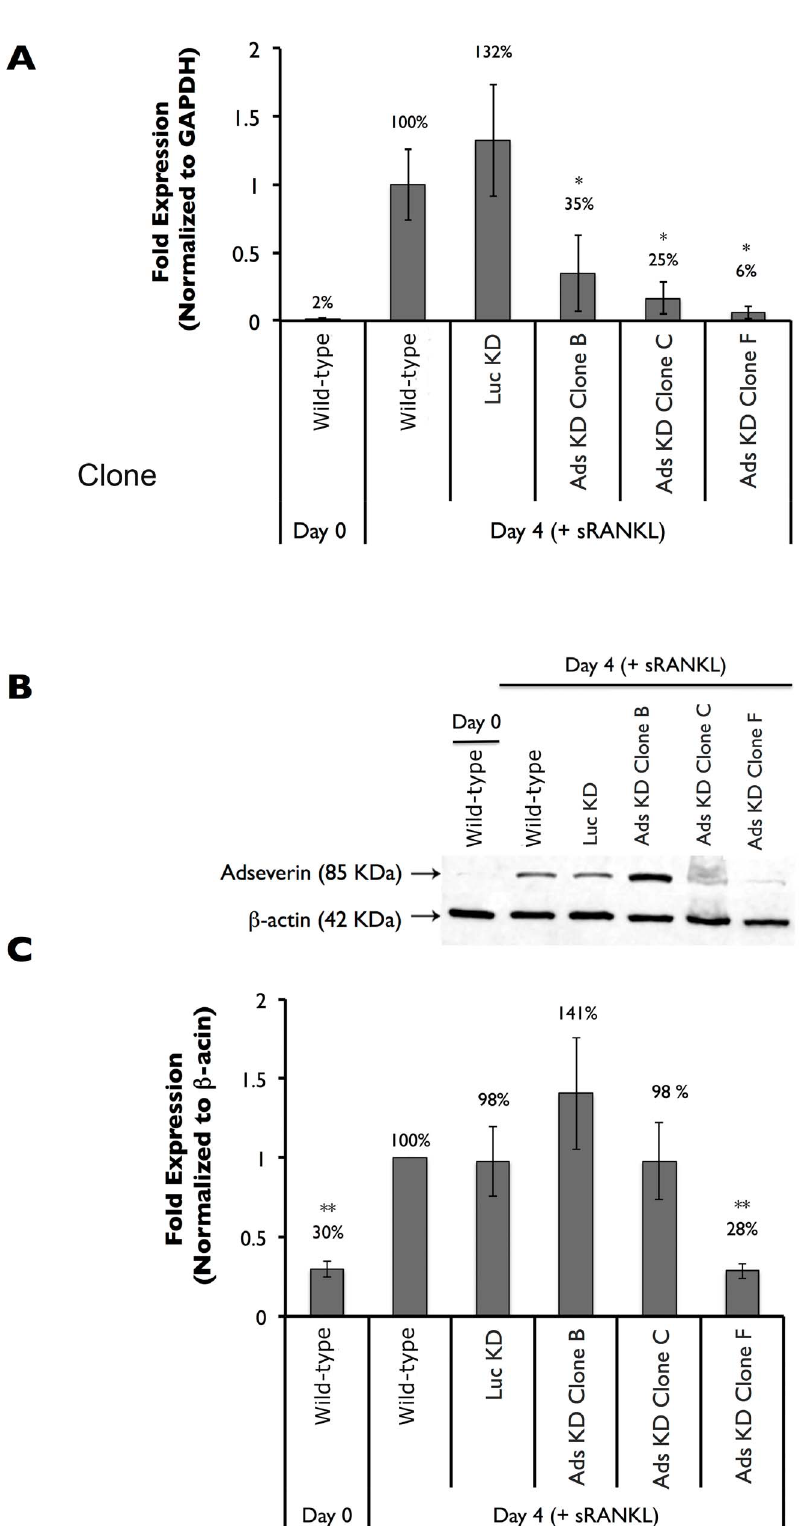
Figure 4. Adseverin knockdown clonal cell lines displayed varying degrees of Adseverin attenuation in response to sRANKL. A ) Quantitative real-time PCR was used to quantify Ads gene expression in Day 0 and Day 4 osteoclast cultures. Results are expressed as fold expression versus WT Day 4 and are normalized against GAPDH 6 SEM. Ads gene expression was not significantly different between Day 4 WT and Luc KD cultures. Ads transcript levels were significantly lower in all three Ads KD cell lines. Ads gene expression in Clones B and C were 35% and 25% that of Day 4 WT cultures, respectively. Ads KD Clone F cultures experienced the greatest reduction in Ads gene expression. Transcript levels in Day 4 Ads KD Clone F were similar to Day 0 WT cultures, which translated to 6% of Day 4 WT expression. B ) Immunoblotting was used to quantify Ads protein expression in Day 0 and Day 4 osteoclast cultures. C ) Results are quantified and expressed as fold expression versus WT Day 4 ( 6 SD) and are